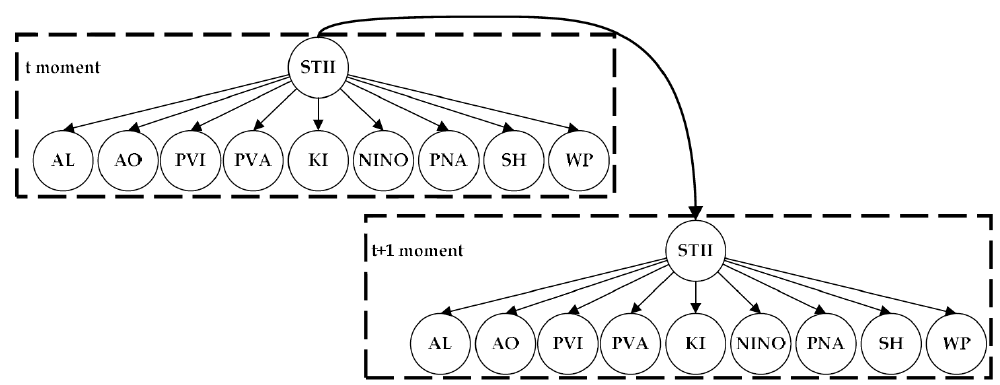
Figure 2. DBN structure between two adjacent time slices of STII prediction.